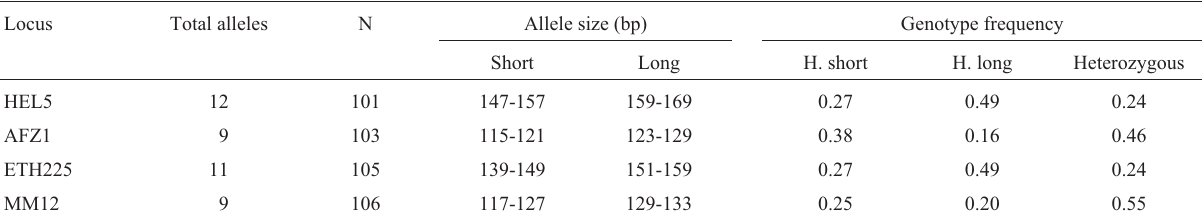
Table2 -Numberofanimals,allelesizesandgenotypefrequenciesoftheindividualsclassifiedashomozygousforshort(H.Short),homozygousforlong (H. Long) and heterozygous. Locus Total alleles N Allele size (bp)